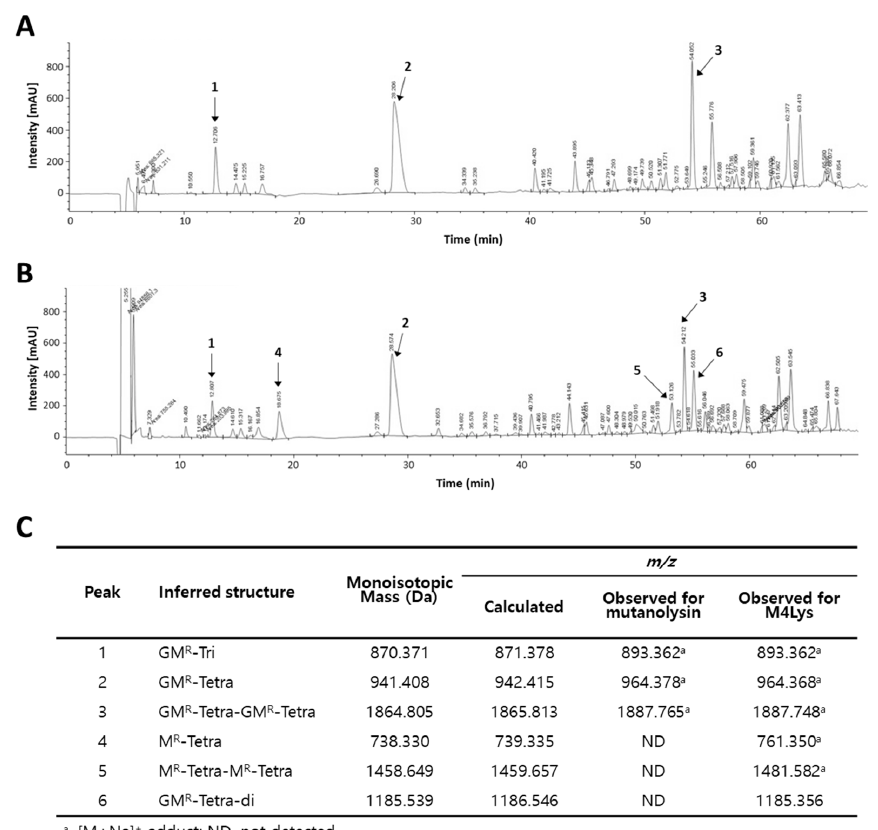
Figure 4. Determination of M4Lys cleavage sites. Analysis of E. coli MG1655 peptidoglycan digested by ( A ) mutanolysin and ( B ) mutanolysin with purified M4Lys ∆ TMD. Soluble muropeptides were reduced and analyzed by RP-HPLC coupled to MS. Peaks corresponding to m / z values matching previously identified muropeptides are numbered. The fragmentation pattern (peaks 1, 2, and 3) is typical of Tri (L-Ala-D-Glu-m-DAP), Tetra (L-Ala-D-Glu-m-DAP-D-Ala), and Tetra-Tetra muropeptides, respectively. The fragmentation event leading to the loss of a nonreduced GlcNAc residue (203.078, theoretical mass; peaks 4 and 5) indicates the N-acetylmuramidase activity of M4Lys ∆ TMD. Cleavage of D-Glu-mDAP crosslink (peak 6) shows the endopeptidase activity of M4Lys ∆ TMD; ( C ) Inferred structures, theoretical monoisotopic masses, and theoretical and observed m / z values of individual peaks are tabulated. M R , reduced MurNAc; G, GlcNAc; Di, m-DAP (meso-diaminopimelic